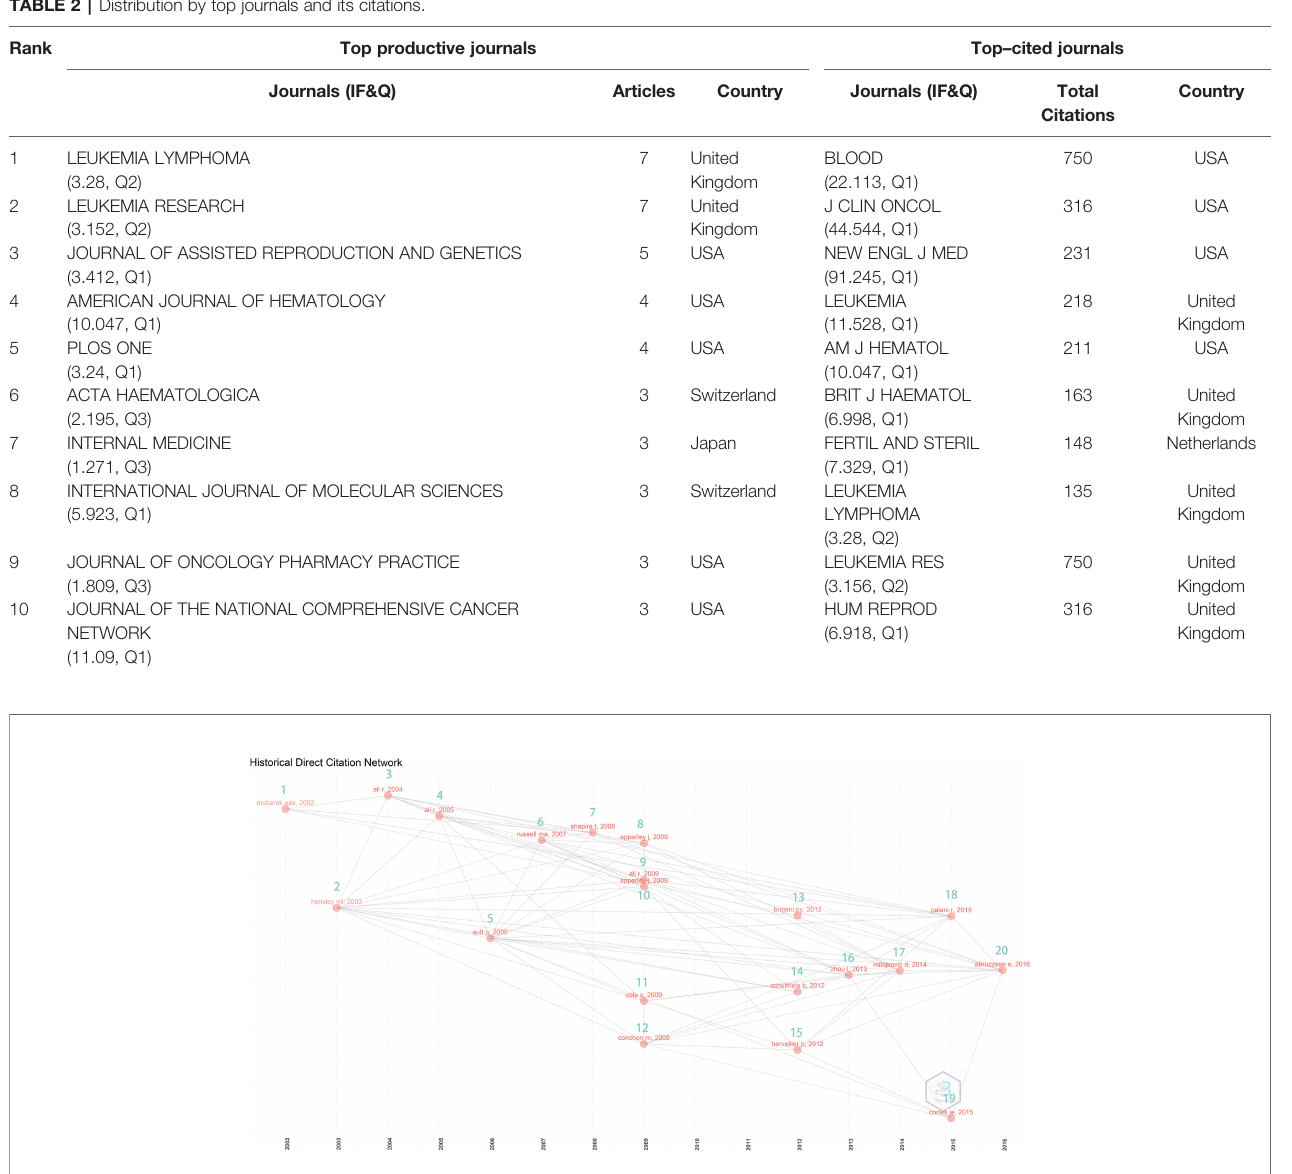
FIGURE 6 | Historical direct citation network of chronic myeloid leukemia in pregnancy